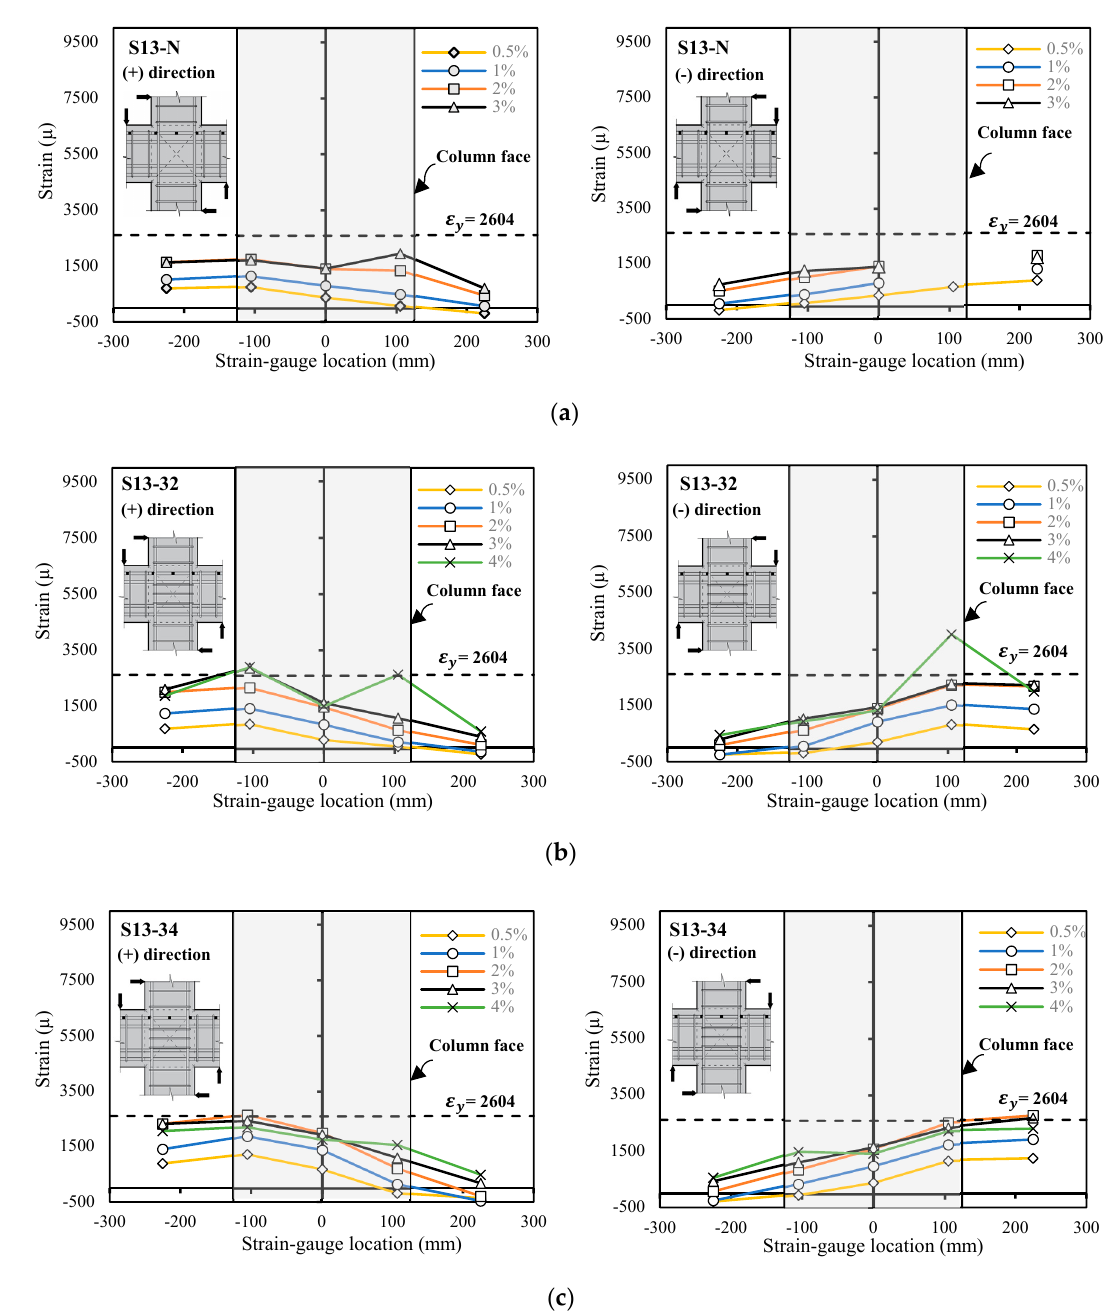
Figure 10. Strain distributions of the beam flexural reinforcement: ( a ) S13-N; ( b ) S13-32; and ( c ) S13-34.